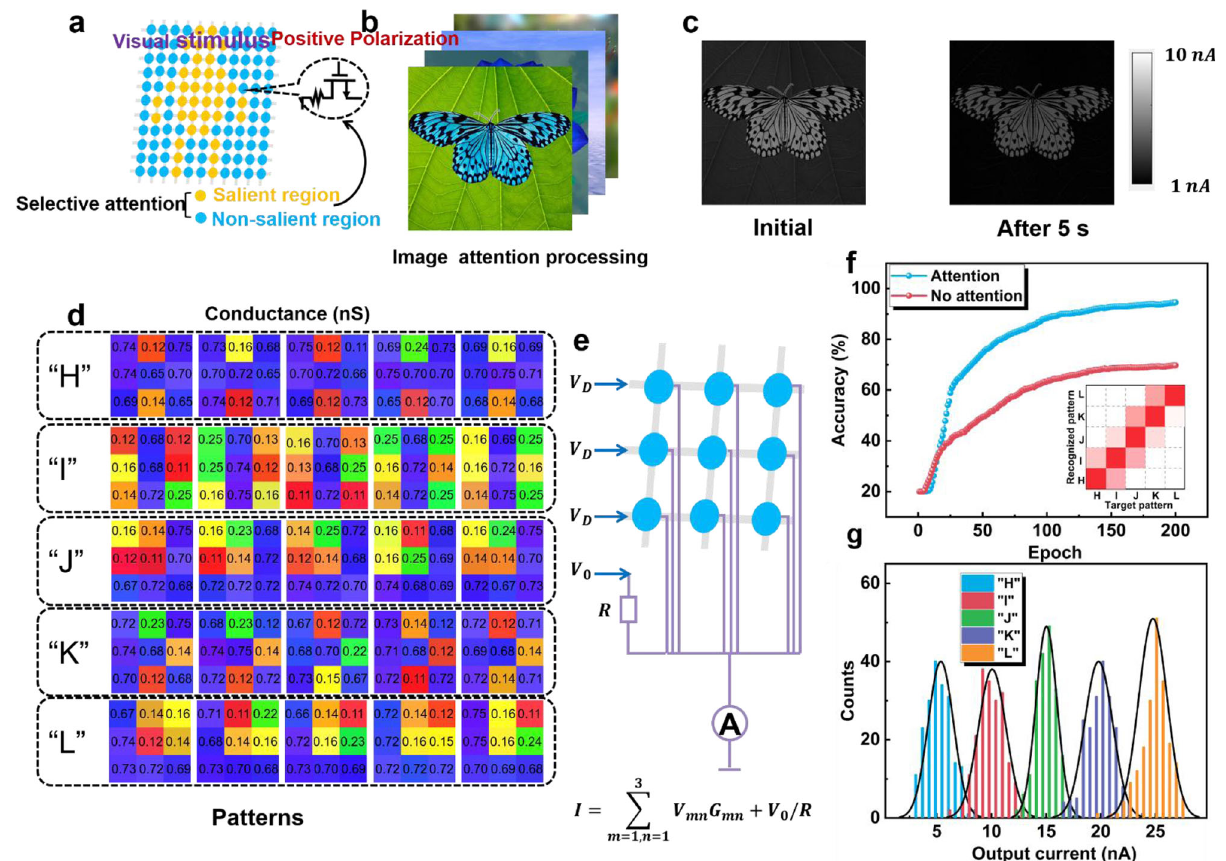
Fig. 5 | Image attention processing and pattern classi fi cation. a Schematic illustration of the structure of image processing array. b Processing images with short wavelengths and long wavelengths. c The realization of image attention processingwiththeincreasedofdecaytime. d Thedetectedpatternsof “ H ” , “ I ” , “ J ” , “ K ” , “ L ” letters with different wavelengths and encoding conductance of pattern